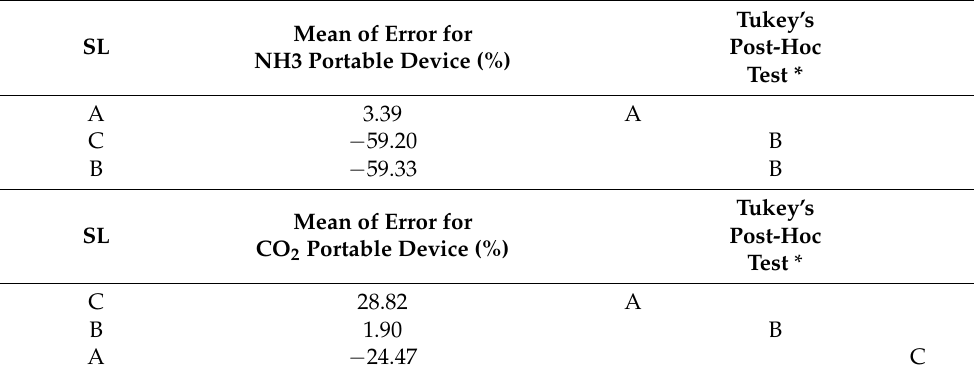
Table 2. Results of the ANOVA ( p < 0.05) carried out for the relative error ε i (%) related to measurements of the gas concentrations of NH 3 and CO 2 at the three sampling locations (i.e., SLA, SLB, and SLC) by using the portable devices.